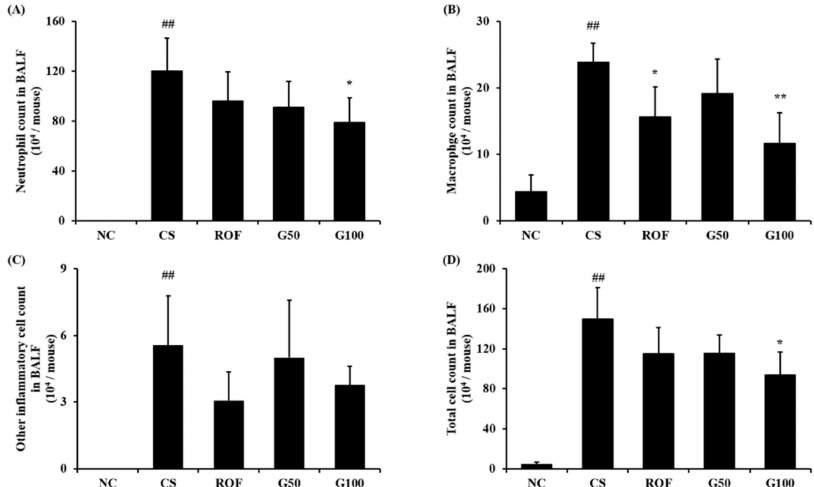
Figure 3. GGWE reduce inflammatory cell counts in bronchoalveolar lavage fluid (BALF). ( A ) number of neutrophils, ( B ) number of macrophages, ( C ) number of other cells and ( D ) number of total cells. NC, non-treated mice; CS, CS and LPS exposure mice; ROF, roflumilast 10 mg/kg and CS and LPS exposure mice; G50, GGWE 50 mg/kg and CS and LPS exposure mice; G100, GGWE 100 mg/kg and CS and LPS exposure mice. The values shown are the mean ± SD. ## p < 0.01 vs. NC; # p < 0.05 vs. NC; ** p < 0.01 vs. CS; * p < 0.05 vs. CS.